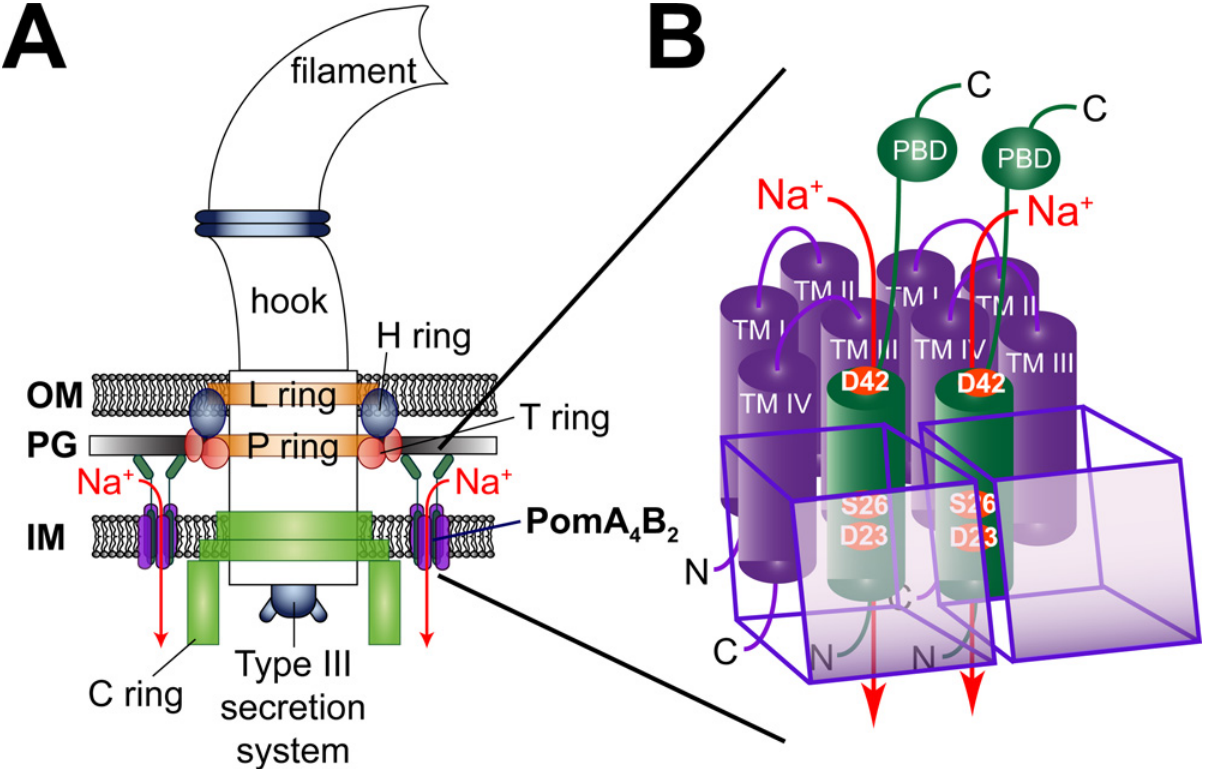
Fig 1. Rotation of the single polar flagellum from V . cholerae is driven by a Na + flux through the PomA 4 PomB 2 stator complex. A: The flagellum of V . cholerae consists of rotating and static parts. The filament, the hook, which connects the filament to the motor complex, the membrane embedded L and P rings in the outer membrane (OM), and the C ring in the inner membrane (IM) rotate against several stator complexes, each composed of four PomA and two PomB proteins. The H ring functions as a bushing to enable rotation against the peptidoglycan layer (PG). The T ring connects the stator complexes with the peptidoglycan layer. Proton-driven flagella, such as found in E . coli and Salmonella , do not have H and T rings. Export of protein components of the flagellar filament is catalyzed by a type III secretion system located at the base of the flagellum. B: Four PomA and two PomB subunits form the flagellar stator complex. PomA possesses four transmembrane helices (TM I – IV), PomB only one. The translucent, purple boxes in the front each represent one PomA subunit. The flux of Na + through the stator complex (red arrow) along the chemical gradient drives the rotation of the C ring against the stator elements. It is assumed that Na + ions pass through a channel built by helices III and IV of PomA and the single transmembrane helix of PomB [17,31]. The peptidoglycan binding domain (PBD) in the C-terminal part of PomB stabilizes the stator complexes within the peptidoglycan layer. The conserved amino acid residues D42, S26 and D23 of PomB promote the transport of Na + through the stator